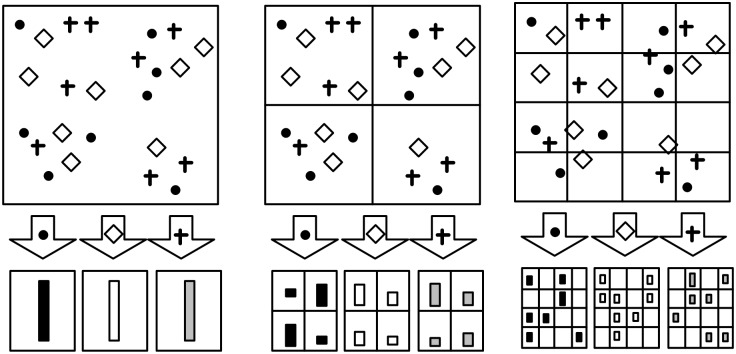
An example for SPM.